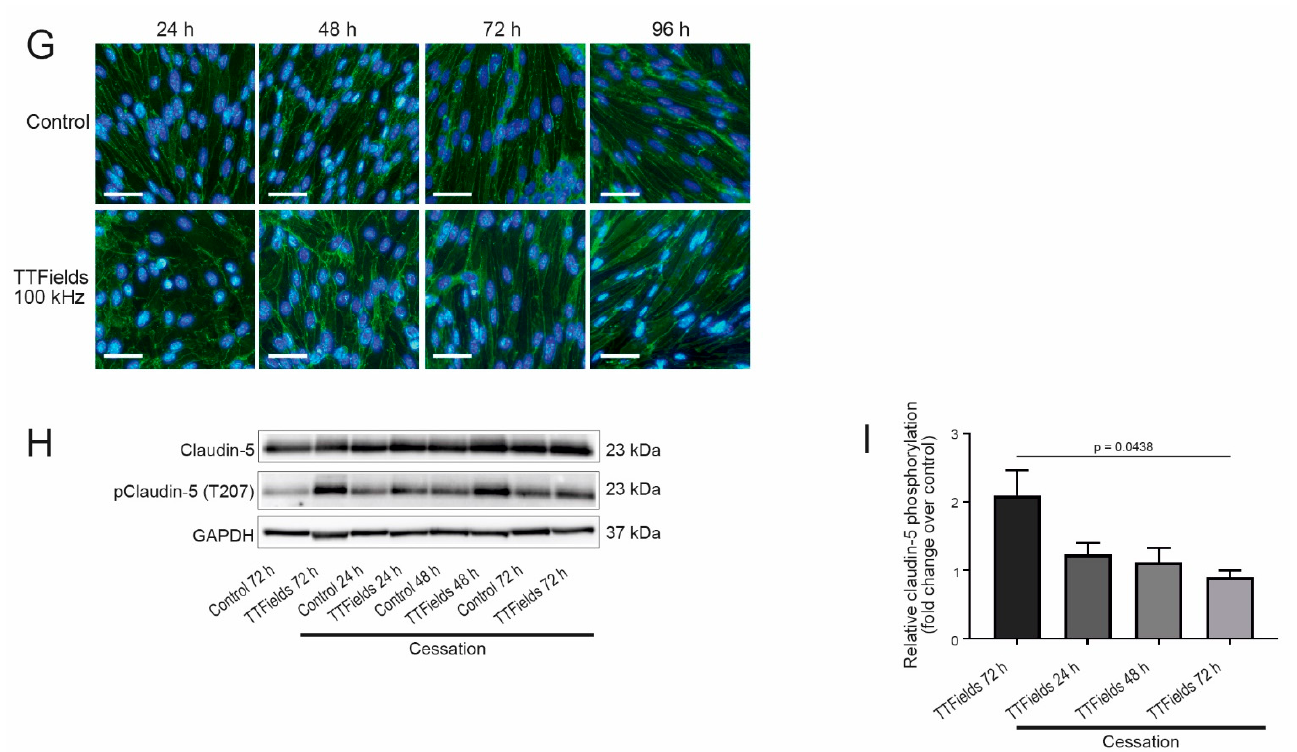
Figure 2. TTFields application promoted phosphorylation of claudin-5 in a ROCK-dependent manner. ( A ) Western blot analysis of GEF-H1 phosphorylated on S885 and claudin-5 phosphorylated on T207 in control and TTFields-treated cells. ( B ) Quantification of normalized relative levels of phosphory- lated compared to total levels of GEF-H1 from three to four Western blots for each condition. Asterisks indicate significant differences compared to the control. ( C ) RhoA activation was measured by the RhoA G-LISA activation assay. ( D ) Quantification of normalized relative levels of phosphorylated compared to total levels of claudin-5 from three to four Western blots for each condition. Asterisks in- dicate significant differences compared to the control. ( E ) ROCK activity expressed as the ratio of the OD of treated cells to the OD of untreated cells. Asterisks indicate significant differences compared to the control. ( F ) Inhibition of ROCK with 10 µ M fasudil in cerebEND cells treated with TTFields at 100 kHz for 72 h and untreated controls. Immunofluorescence staining with antibody against claudin-5 (green). Nuclear staining with DAPI (blue), scale bar = 50 µ m. Shown are representative images of n = 3 independent experiments. ( G ) Cells treated with TTFields at 100 kHz for 72 h were allowed to recover for 24, 48, 72, and 96 h at 37 ◦ C. They were then stained with antibody against claudin-5 conjugated to Alexa Fluor 488 (green). Nuclei were stained with DAPI (blue), magnifica- tion 40 × , scale bar = 200 µ m. Shown are representative images of n = 3 independent experiments. ( H ) Western blot analysis of phosphorylated claudin-5 after end of TTFields treatment. ( I ) Quantifica- tion of normalized relative levels of phosphorylated claudin-5 compared with total claudin-5 levels from two to four Western blots for each condition. OD, optical density. The stated p -value refers to differences between TTFields 72 h and the corresponding 72 h time point after TTFields cessation. To further visualize the involvement of ROCK in claudin-5 delocalization upon TTFields administration, cerebEND cells were treated with fasudil, a clinical agent known to inhibit ROCK [39], prior to immunofluorescence staining. With the application of 10 µ M fasudil, the distribution of claudin-5 in the cells to which TTFields were applied appeared more like untreated control cells that did not receive any treatment, than to cells that were subjected to TTFields but not fasudil (Figure